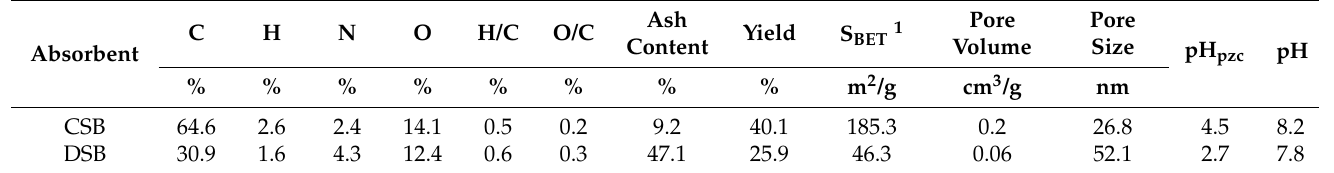
Table 1. Physical and chemical properties of corn straw and dewatered sludge biochars (CSB and DSB).